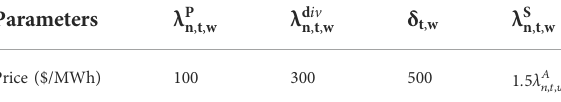
TABLE 1 Parameter setting of prices.